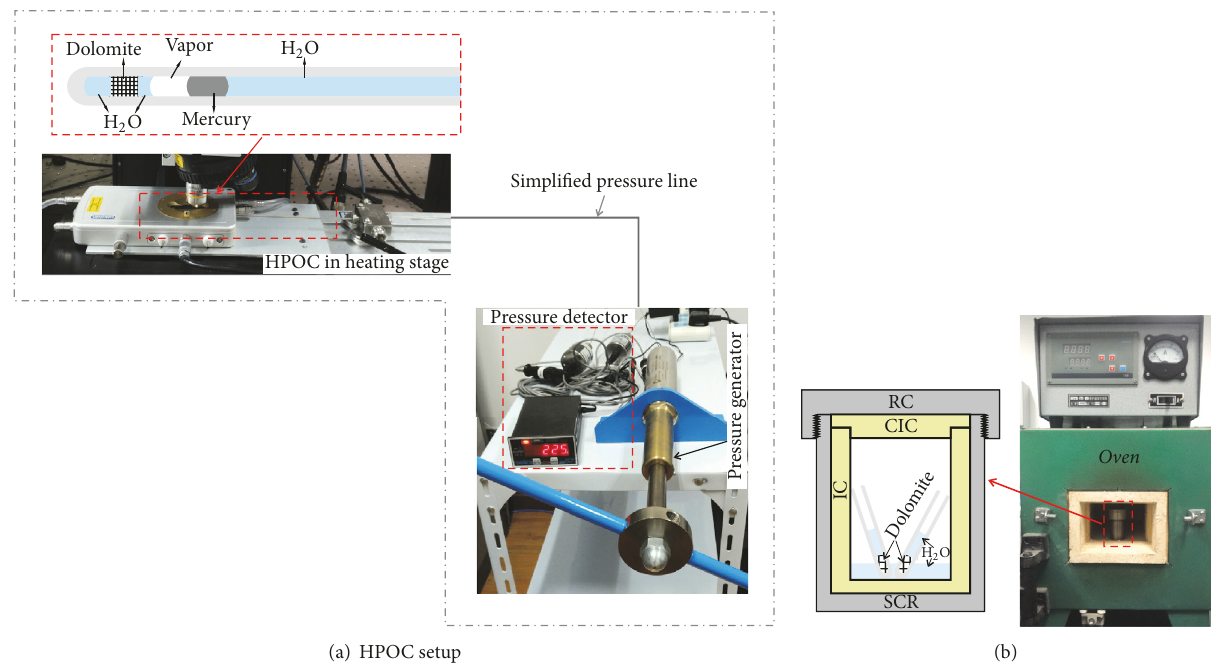
Figure 2: (a) The setup for measurements of the internal pressures within a HPOC containing dolomite and water; (b) the batch stainless reactor in the oven. The left schematic diagram showing the structure of the reactor. SCR represents the stainless cup of the reactor, RC represents the reactor cover, IC represents internal cup, and CIC represents cover of the internal cup.